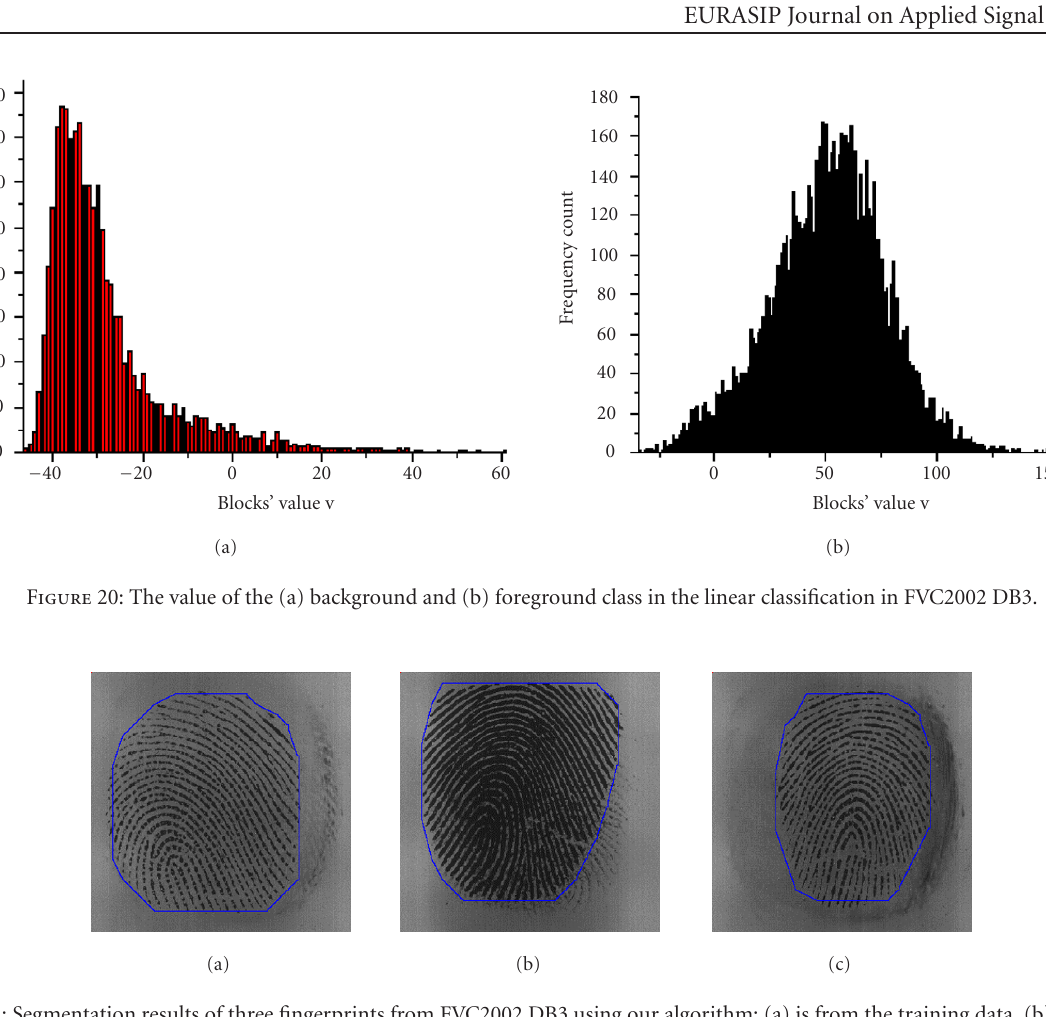
Figure 21: Segmentation results of three fingerprints from FVC2002 DB3 using our algorithm: (a) is from the training data, (b) and (c) are from the test data.